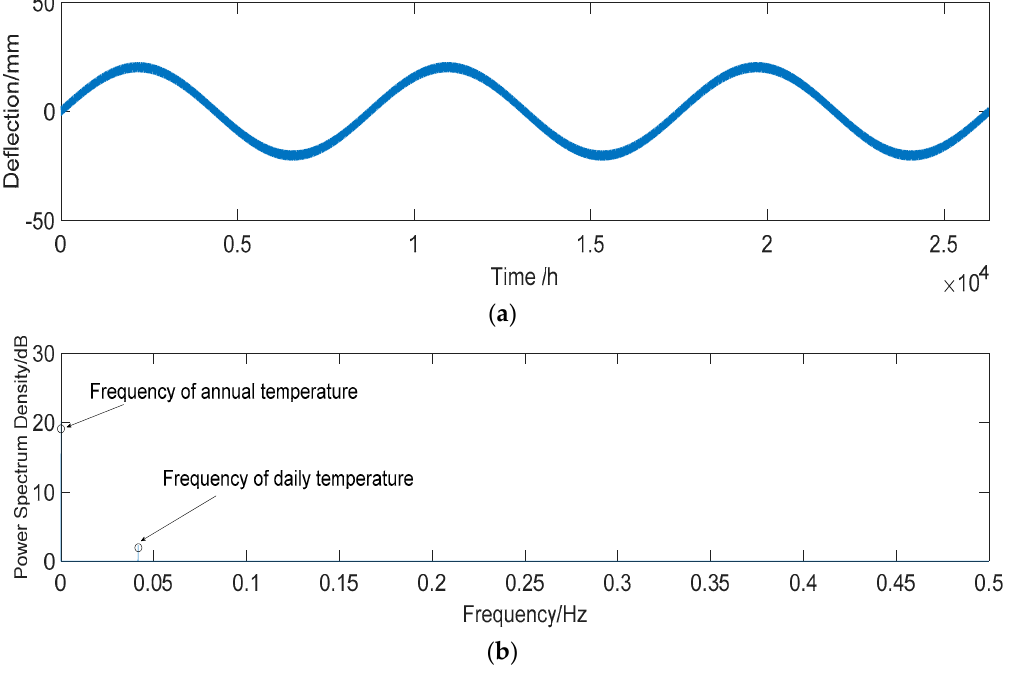
Figure 7. Characteristics of the deflection of temperature effect D T . ( a ) Three years’ time history of temperature effect deflection D T . ( b ) Power spectrum of D T . The sampling frequency is regarded as 1 Hz.